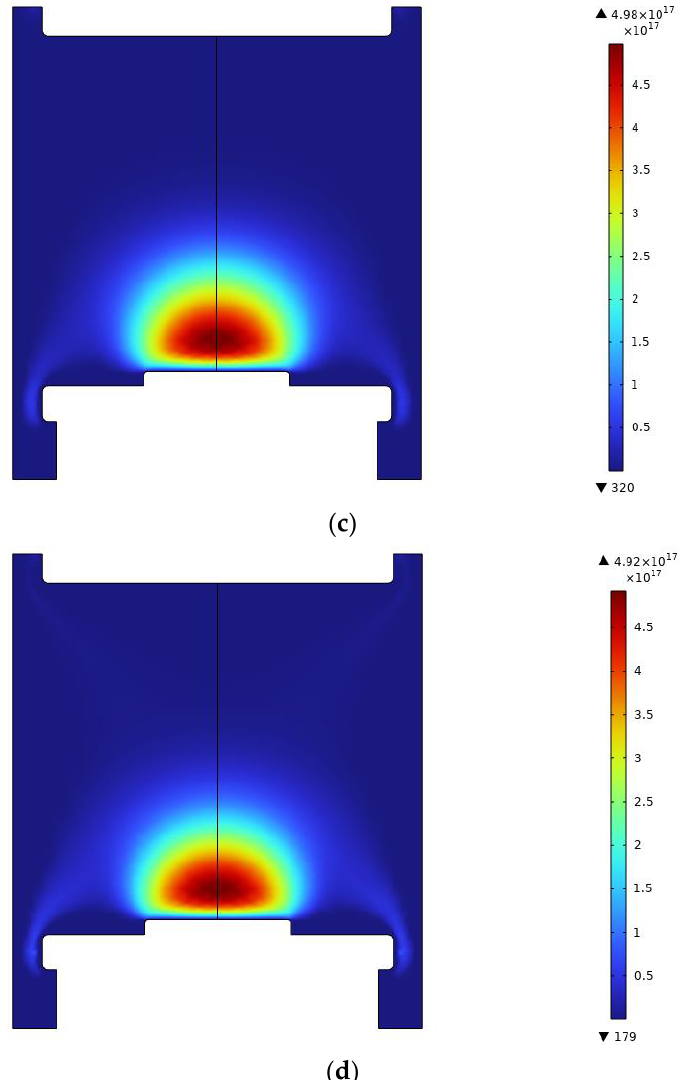
Figure 7. Contour plots of electron density distribution in the deposition chamber (1/m 3 ). ( a ) 0 V; ( b ) +100 V; ( c ) +200 V; and ( d ) +300 V.